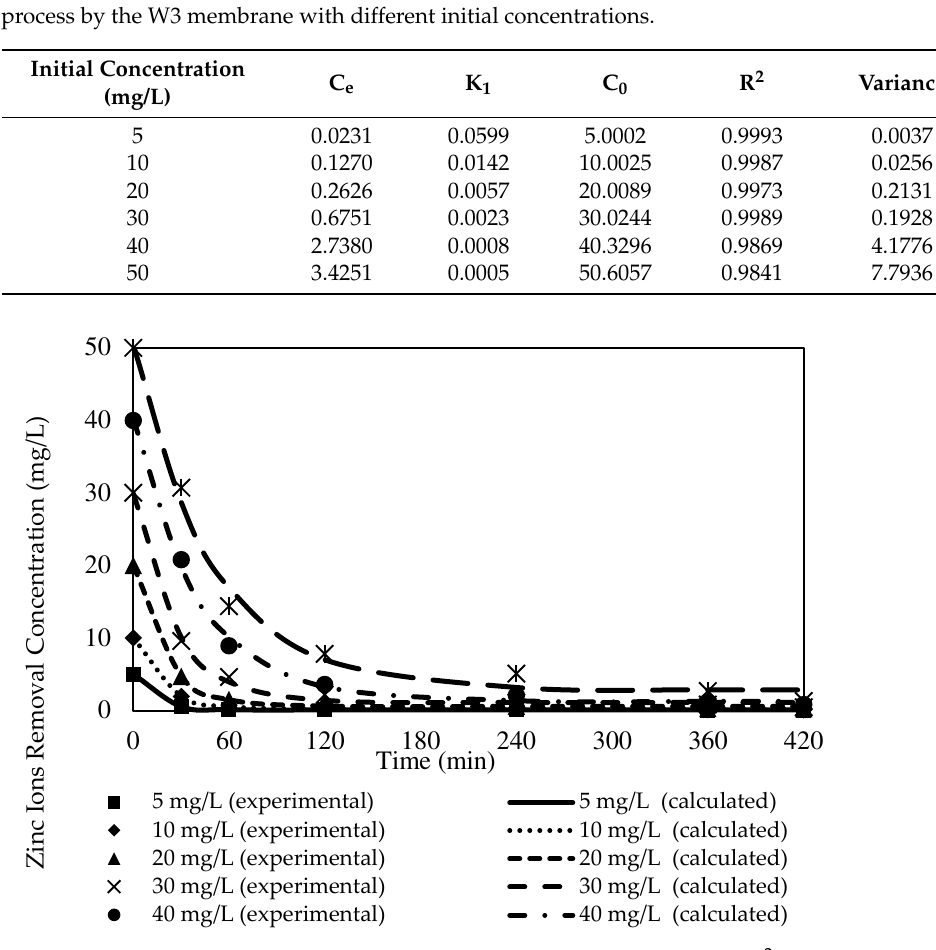
Figure 16. Fitting of the experimental data to the PFO model describing Zn 2+ removal by the W3 membrane over time at different initial source phase concentrations.